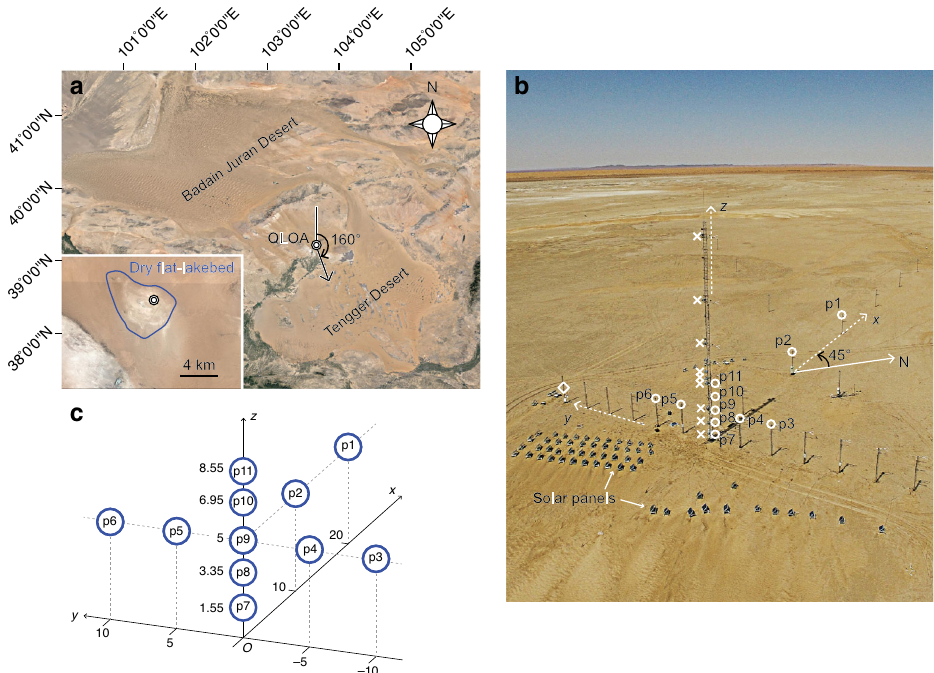
Fig. 1 Location of the QLOA site and con fi guration of measurement array in this study. a The QLOA site located at approximately 39 (cid:1) 12 0 27 00 N, 103 (cid:1) 40 0 03 00 E, and altitude around 1302 m. An arrow represents the prevailing wind direction at the QLOA site, where wind direction is measured in degrees clockwise from due north. The inset shows the area of the dry fl at-lakebed of Qingtu Lake (credit: Google Earth Pro). b Cartesian coordinate system de fi ned in this study. The positive direction of the x -axis points toward the northwest (at an angle of 45 ∘ anticlockwise from due north). The E- fi elds were measured at the points that are marked by open circles( ∘ ) and labeled at p1-p11, the PM 10 dust concentrations were measured at the points that are marked by crosses (×), as well as the ambient T, RH, and visibility were measured at the point that is marked by a diamond ( ◇ ). The wind velocity was measured at p9. c The coordinates of the E- fi eld measurement points p1-p11 are shown in units of (VREFMs) were deployed at the QLOA to measure the 3D E- fi elds within 30 m height above the ground during dust storms (Fig. 1b). The detailed arrangement of VREFMs is shown in Fig. 1c and Supplementary Table 1. The VREFM functions as a vibrating capacitor, where the ambient E- fi eld component normal to the electrode is measured by detecting the induced charge on the electrode. The VREFM recorded data at 1 Hz with an